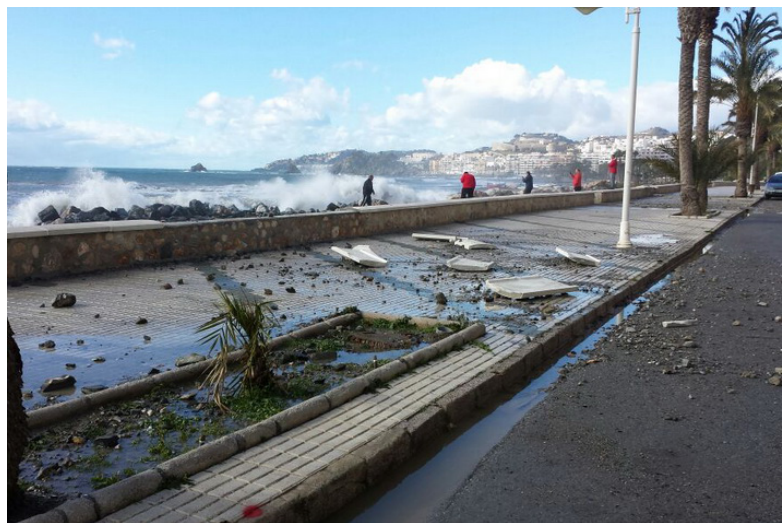
Figure 2. Severe damage after a western storm in winter 2015 at the Reina Sofia Promenade (Almuñecar), photo by